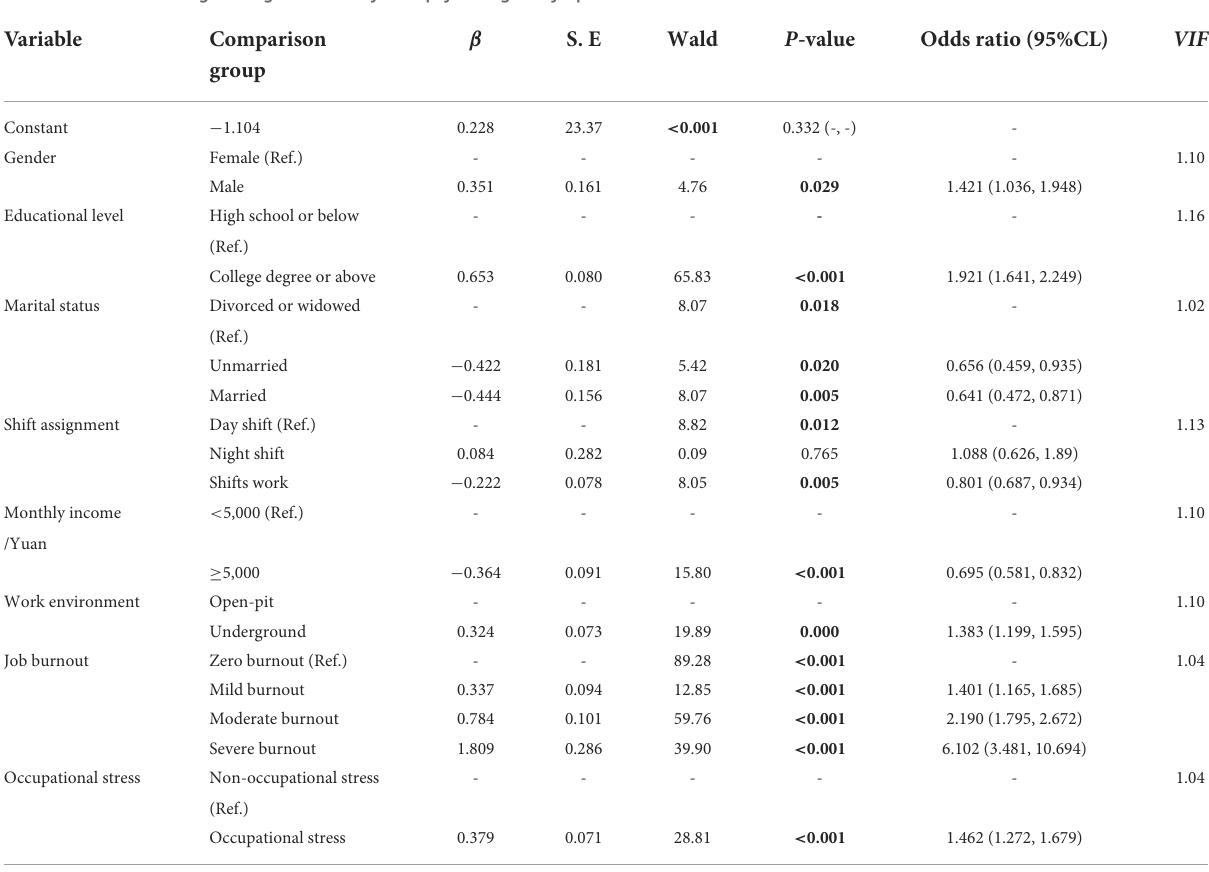
TABLE 6 Multivariate logistic regression analysis of psychological symptoms.